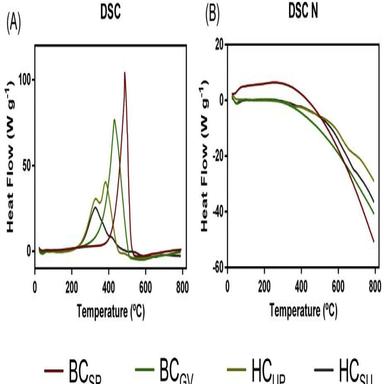
Differential scanning calorimetry (DSC) profile of samples in air atmosphere (A) and nitrogen atmosphere (B).